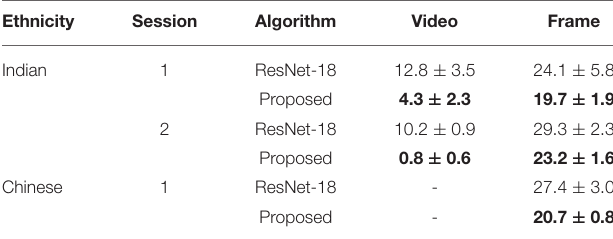
TABLE 6 | Characteristics of the existing VIS spectrum attack database used in this